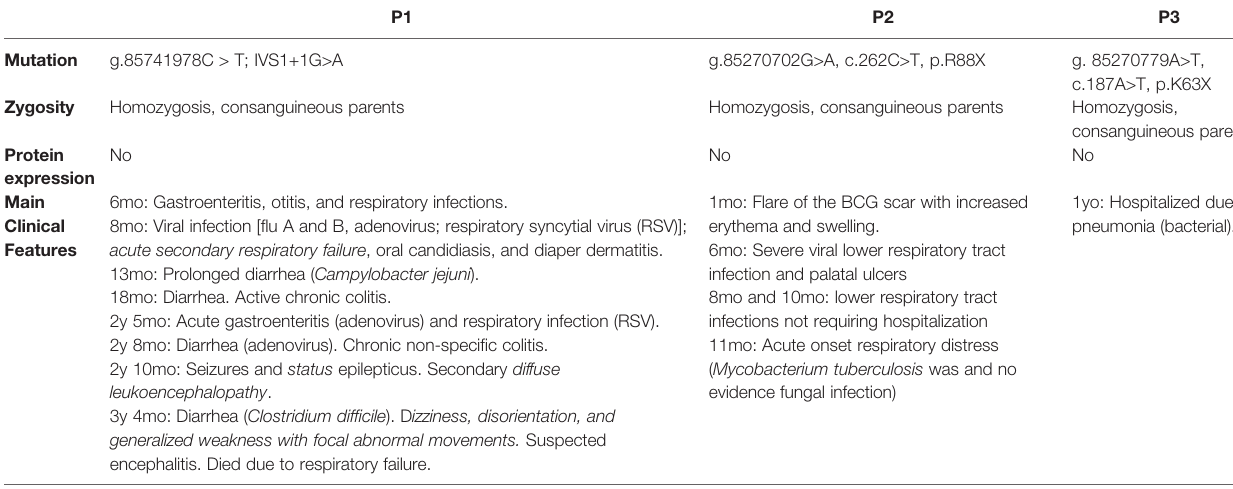
TABLE 1 | Summary of the main genetic, clinical, immunological, and cellular features comparing the three BCL10-de fi cient patients reported.